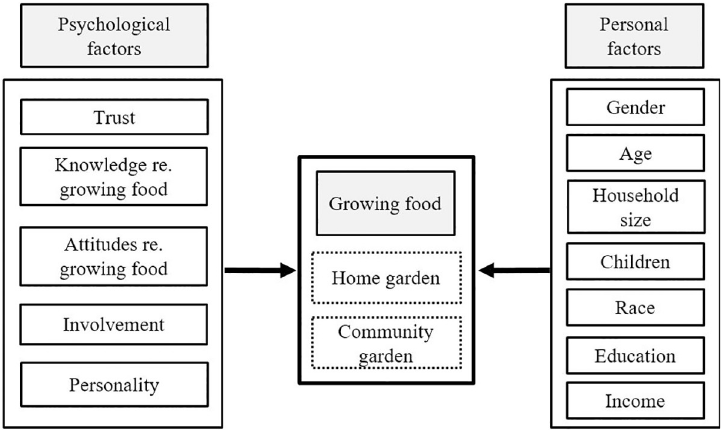
Fig 1. Conceptual framework: Socio-behavioral factors of participation in small-scale urban